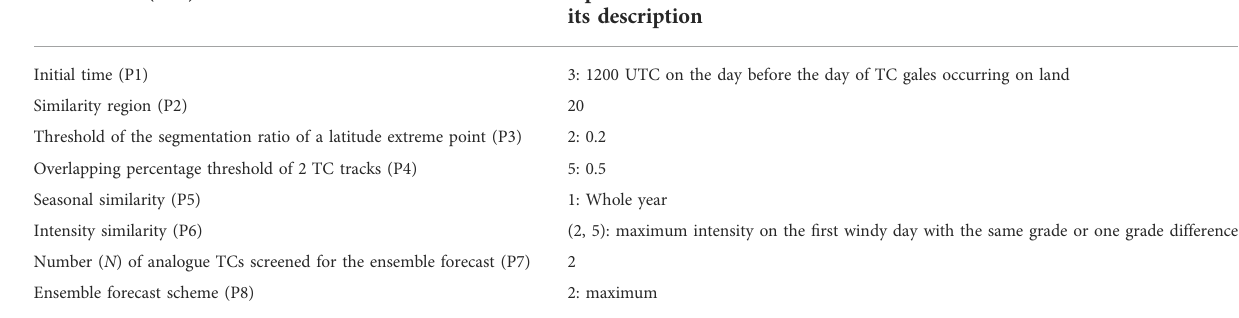
TABLE 4 Optimized values for the best forecast scheme in the simulation experiment.